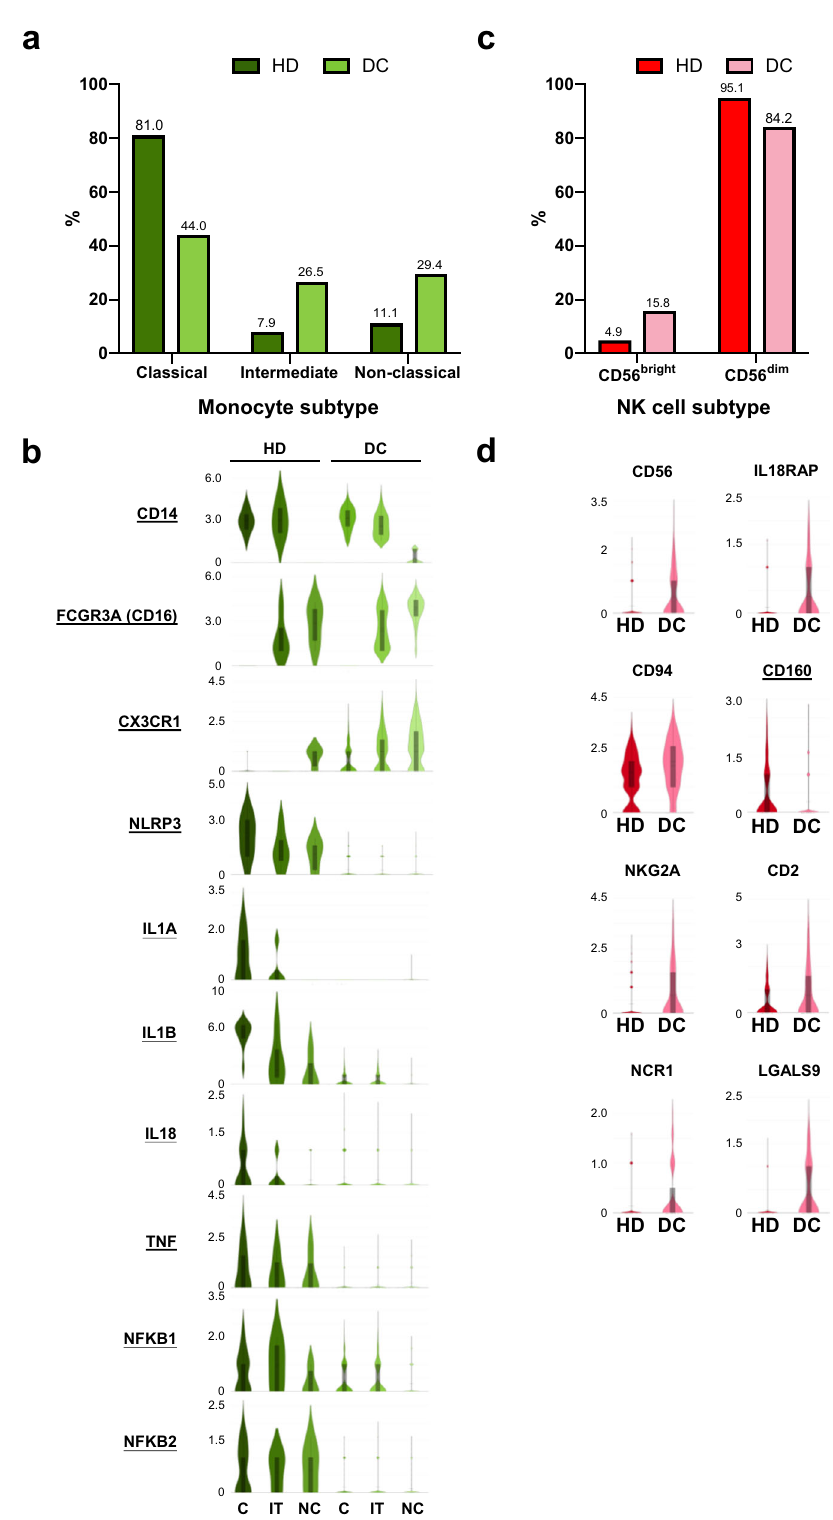
Fig. 3 Single-cell RNA-Seq analysis reveals distinct contributions of monocyte and NK-cell populations in the DC patient. a Bar graph showing proportions of distinct monocyte subsets relative to their total monocyte counts in the healthy donor and DC patient, respectively. b Violin plots showing the differential expression distribution of monocyte-associated genes between the healthy donor and DC patient in classical, intermediate, and nonclassical monocytes. The box represents the interquartile range; The whiskers represent the rest of the distribution. c Bar graph showing the proportions of the CD56 bright and CD56 dim subsets in the healthy donor and DC patient. d Violin plots showing the differential expression distribution of NK-cell-associated genes between the healthy donor and DC patient. The box represents the interquartile range; The whiskers represent the rest of the